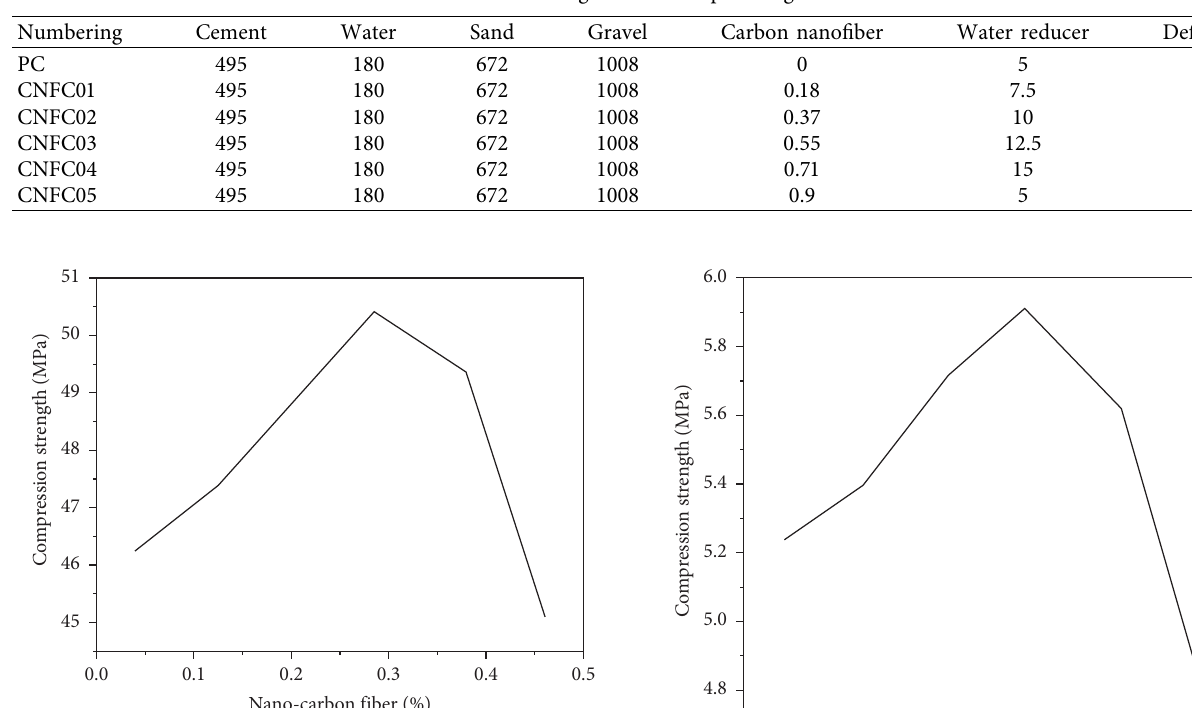
Table 3: Mixing ratio of test pieces kg/m 3 .